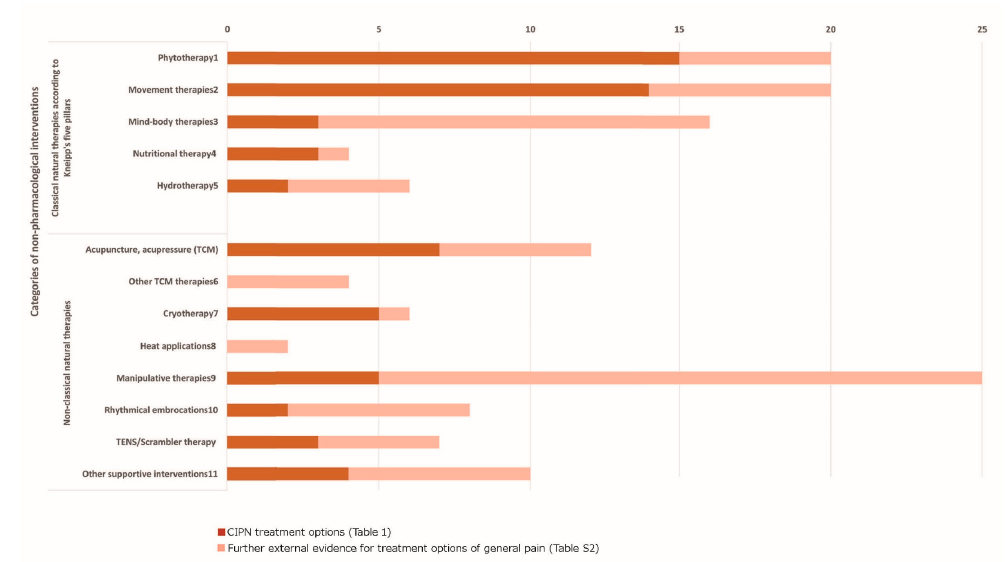
Figure 2. Overview of number of evidence sources for CIPN and general pain. Legend of Figure 2.